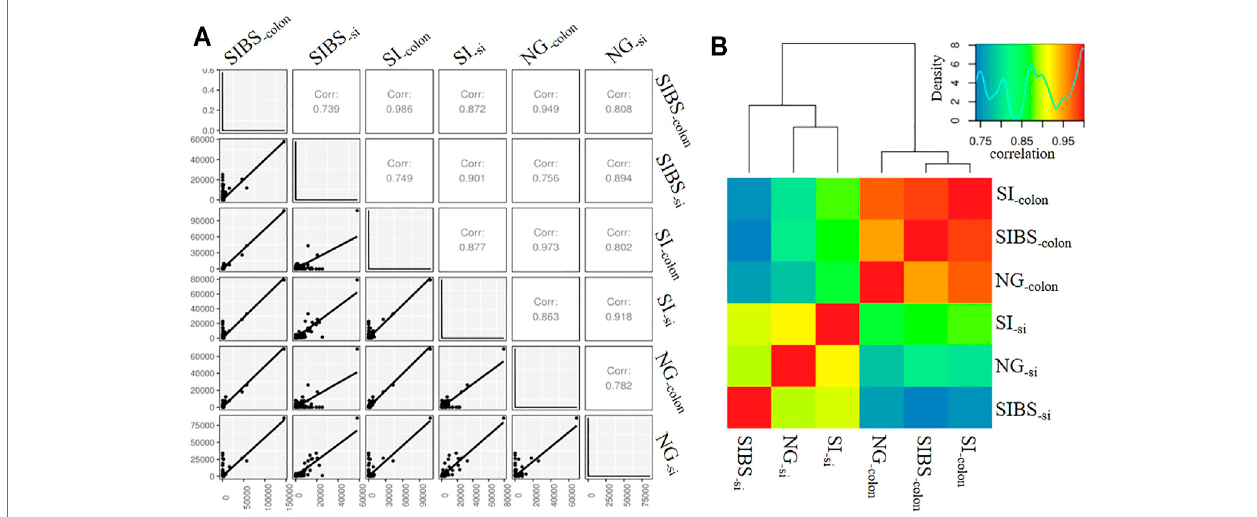
FIGURE4| Thecorrelation ofintestinalmRNA expression pro fi les betweengroups. (A) Correlationshown bygenecorrelation. (B) Correlationshown byheatmap. NG:normalmicewithPBSgroup.BS:normalmicewithOA B.subtilis group.SI: S.japonicum – infectedmicegroup.SIBS: S.japonicum – infectedmicewithOA B.subtilis group. “ -colon ” indicates colon tissue. “ -si ” indicates small intestine tissue.